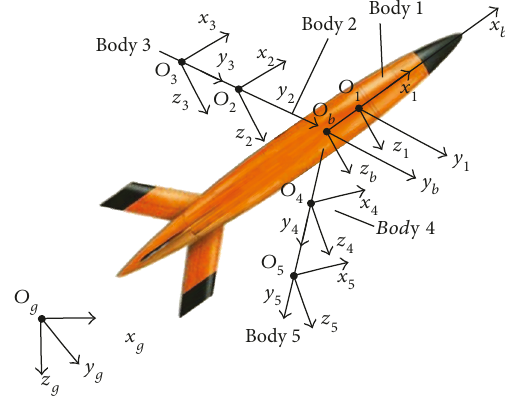
Figure 2: Coordinate axis